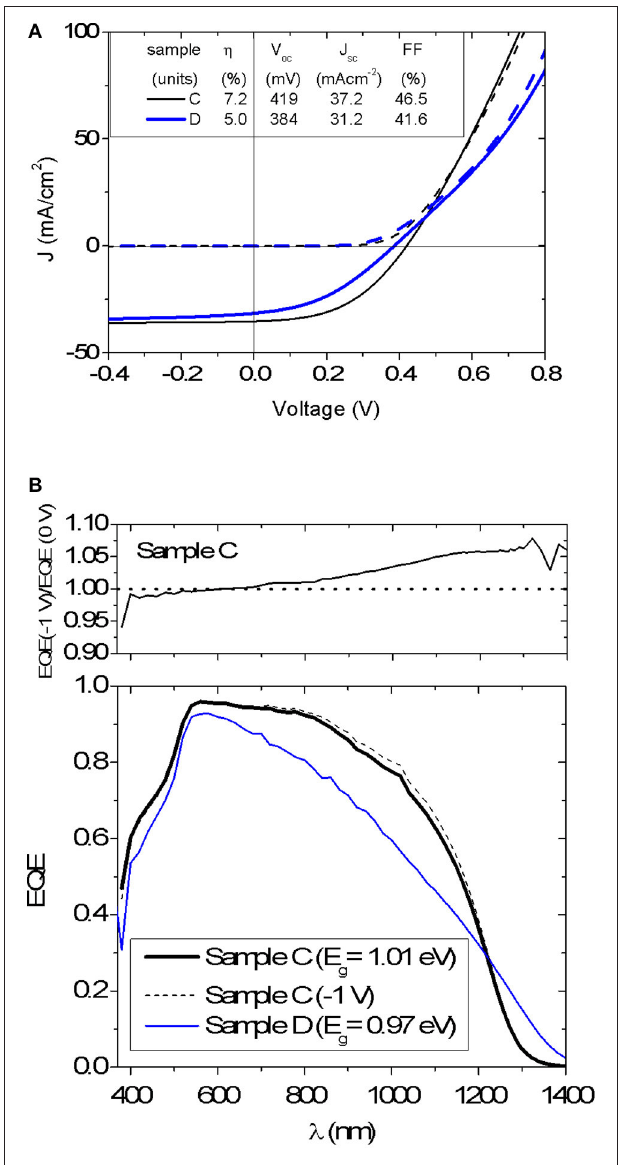
FIGURE 6 | (A) J-V characteristic of the best devices C and D (dark curve—dash line, light curve—solid line). Photovoltaic parameters are also shown and refer to total area measurements. (B) External quantum efficiency of devices C and D. EQE spectrum for device C under a reversed bias of − 1V is also displayed as well as the ratio between voltage biased ( − 1V) and unbiased EQE.